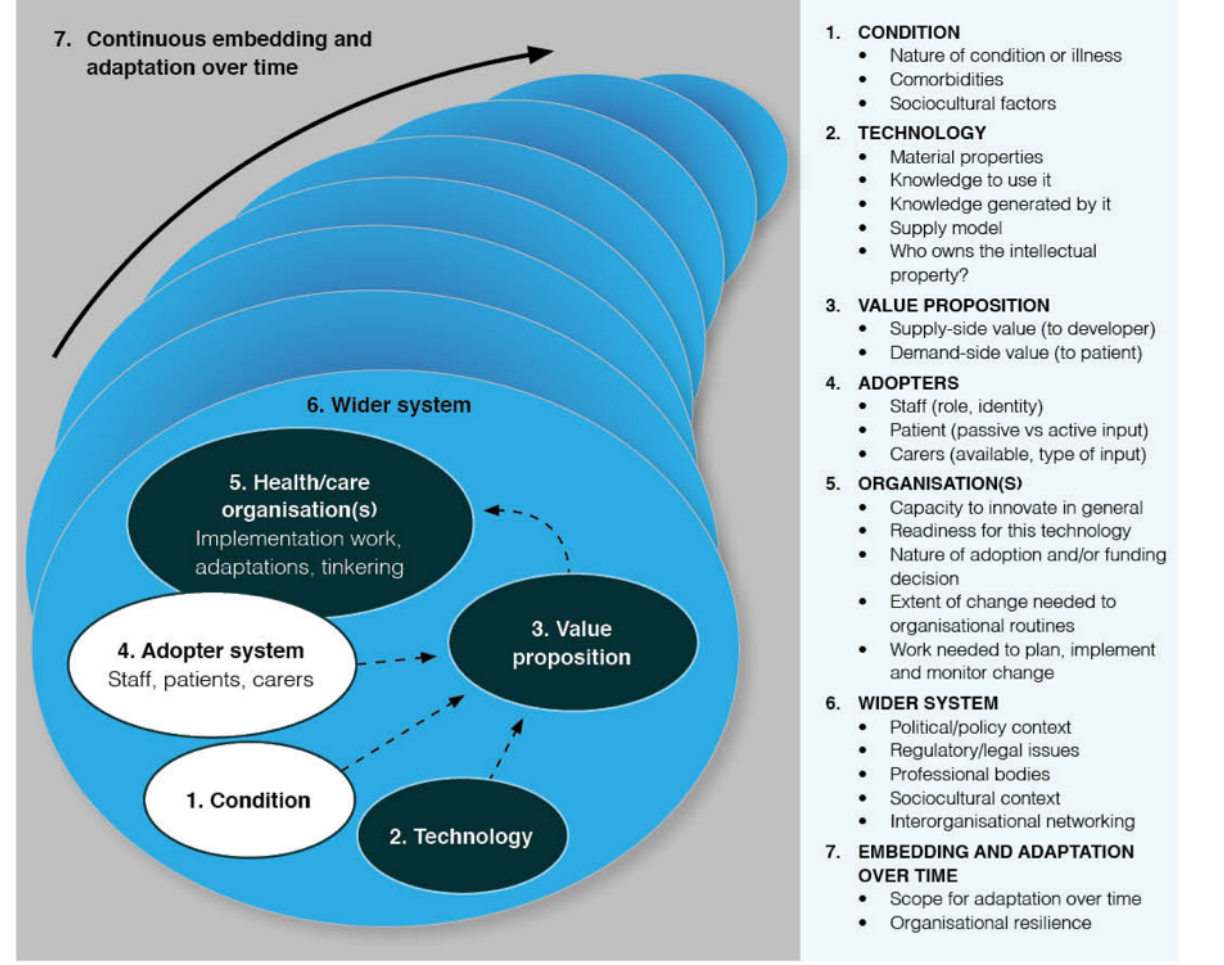
Figure 1. The nonadoption, abandonment, scale-up, spread, and sustainability framework for studying nonadoption and abandonment of